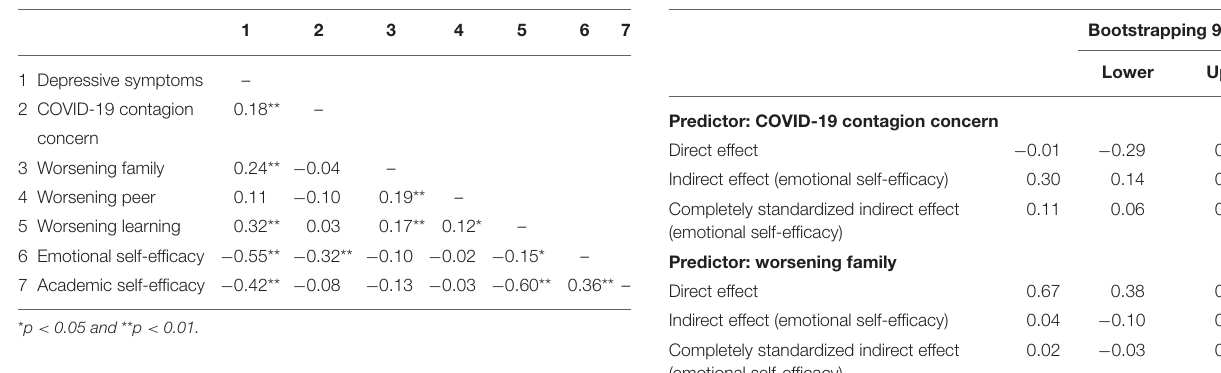
TABLE 5 | Bivariate correlations between study variables. TABLE 6 | Mediation effects in the tested